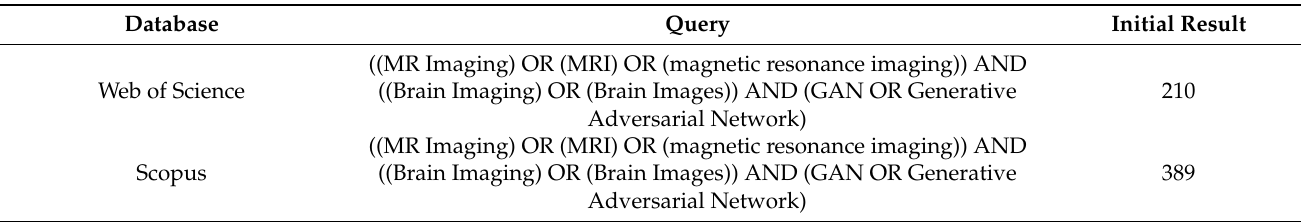
Table 3. Search query used for paper selection related to MRI brain